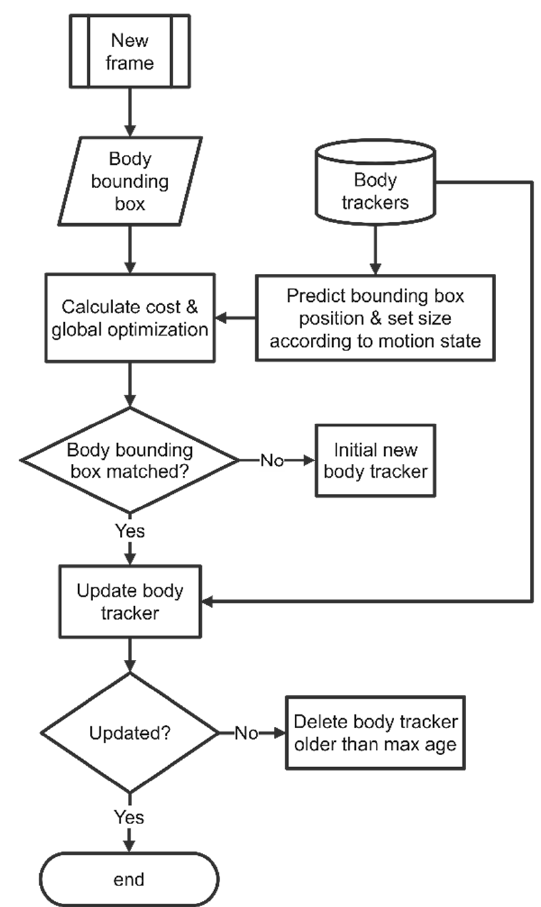
Figure 6. Flow chart of body tracking loop.